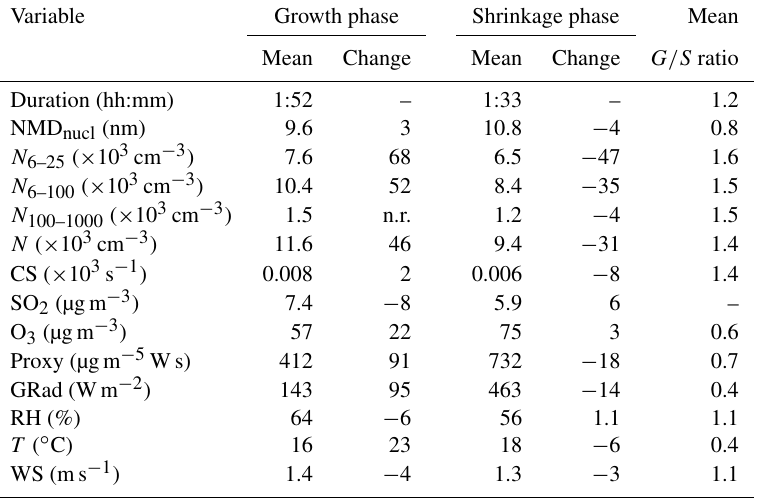
Table 3. Means and their mean relative change rates (in an hour expressed as percentage of the mean) separately for the growth ( G ) and shrinkage ( S ) phases of arch-shaped NPF processes, together with mean G/S ratios of medians for the duration time, nucleation-mode particle number median diameter (NMD nucl ), particle number concentrations in various size fractions ( N 6–25 , N 6–100 , N 100–1000 , N ), condensation sink (CS), SO 2 concentration, O 3 concentration, gas-phase H 2 SO 4 proxy value, global radiation (GRad), relative humidity (RH), air temperature ( T ) and wind speed